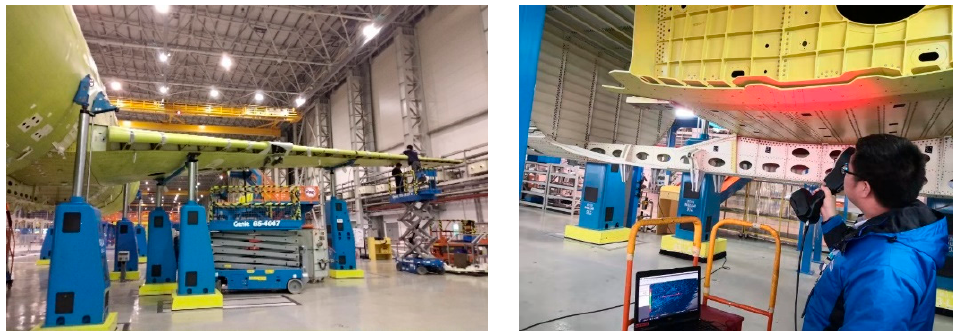
Figure 7. Measurement experiments during wing-body assembly.